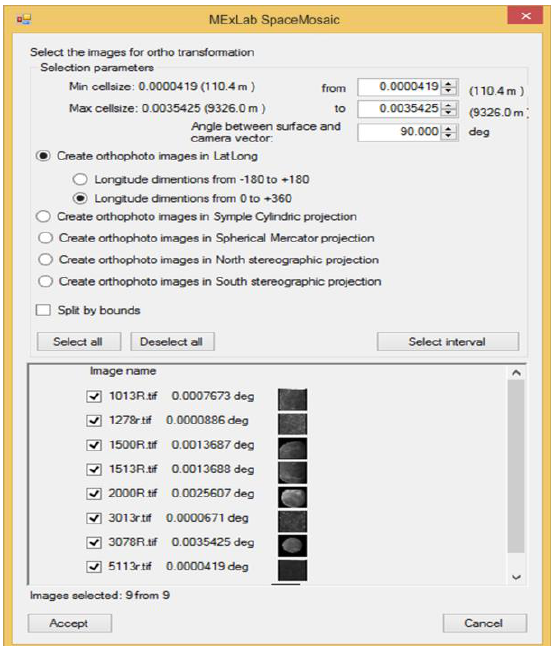
Figure 9. User interface of the SpaceMosaic module implemented for orthorectification of Ganymede